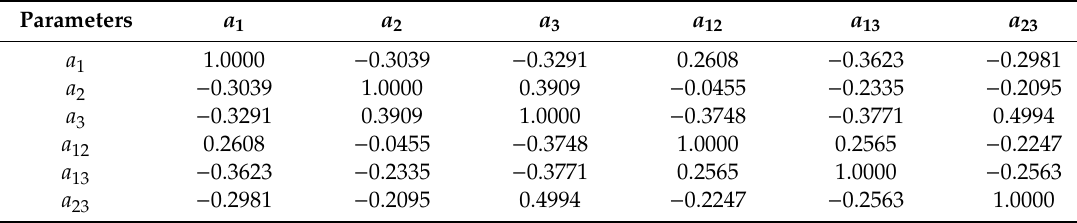
Table 8. Matrix correlation coefficients.